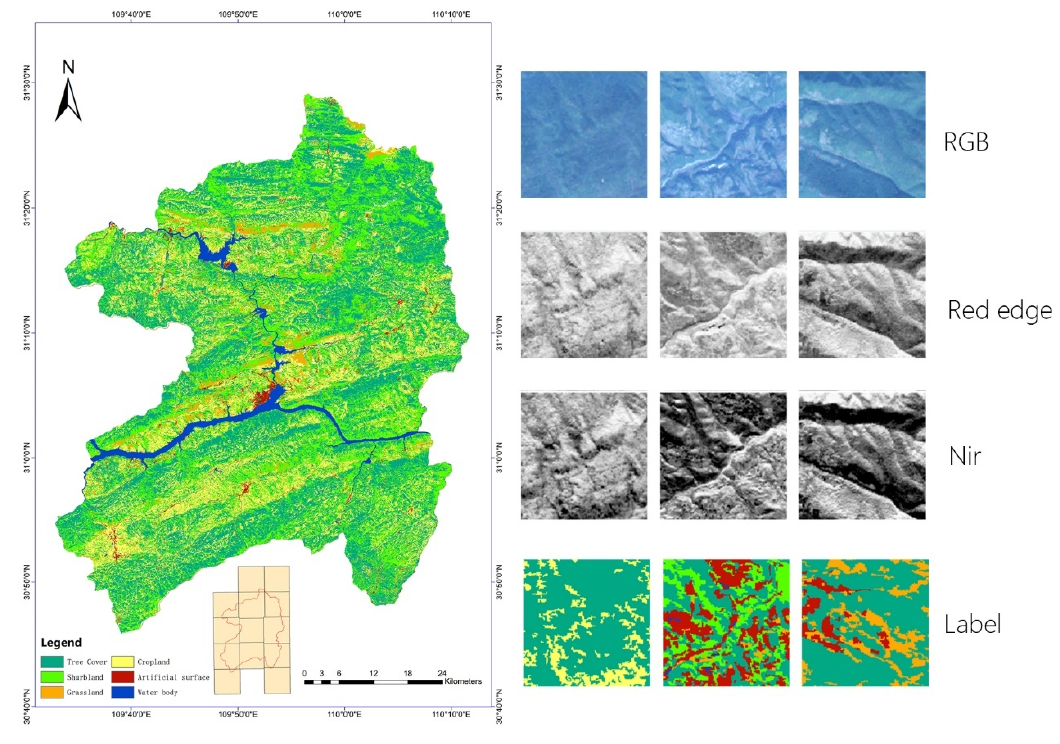
Figure 4. The study area, Wushan county; the right figure shows the five data bands from visible (RGB) to near infrared (Nir) and the land cover labels used for model